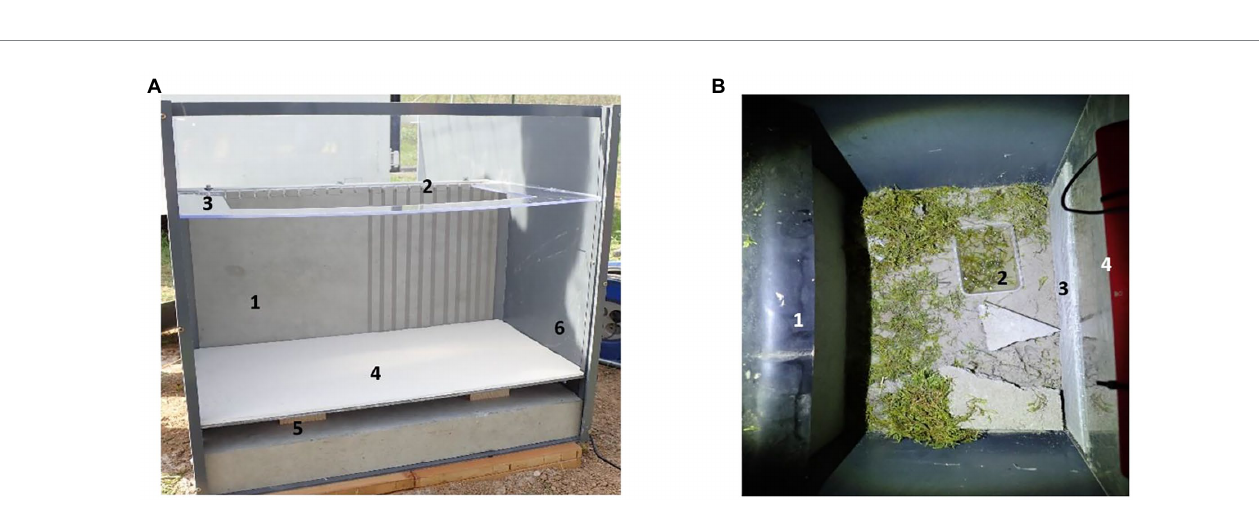
FIGURE 2 Experimental arena. (A) Frontal view of the ‘departure’ compartment: (1) dry part of the vertical concrete fence tested; (2) wet part of the vertical fence tested; (3) anti-escape Plexiglass plate; (4) movable concrete base (30x50 cm, width*length), allowing to adjust fence height; (5) wooden blocks for height adjustments; (6) transparent frontal Plexiglass plate allowing video recording; (B) arial view of the ‘arrival’ compartment: (1) Overhang made from a 7.5 cm wide PVC sheet, that was fixed 5 cm below the top of the fence and bent downwards (inclination angle: ~75 ° ), to prevent animals from returning to the ‘departure’ compartment; (2) small water tank placed among other enrichments: sand, wet moss, hides made of bricks; (3) opening in Plexiglass plate (covered with a mesh) enabling ventilation throughout all compartments; (4) speaker that replayed calls of Epidalea calamita and Pelophylax spp., to stimulate amphibians to cross the